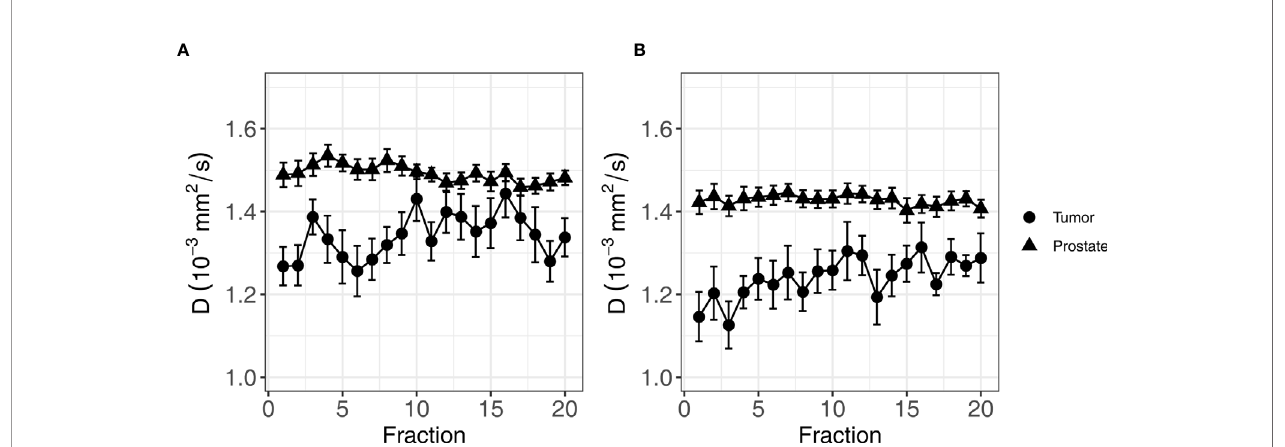
FIGURE 3 | Average of D of all patients over the course of radiotherapy treatment. (A) shows the average for patients in the low ISUP group, and (B) shows the average for patients in the high ISUP group. Error bars indicate the standard error of the mean. As indicated by the result of the mixed effects model, the increase in the high ISUP group (B) is steeper than in the low ISUP group (A) .